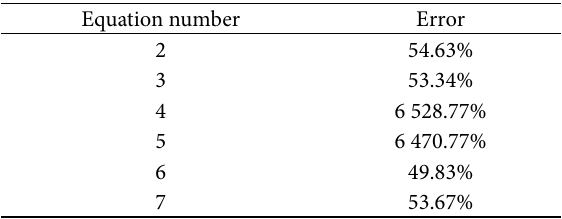
Table 8. The average error of equations listed in Table 7 computed testing the rest of 10% of the analyzed data Equation number Error